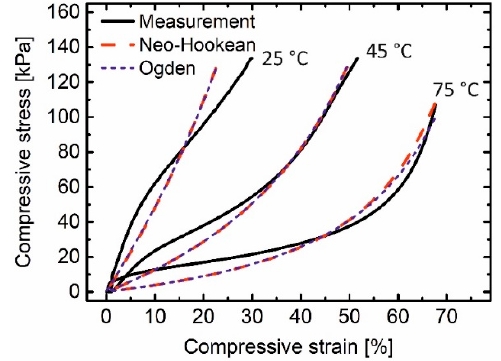
Figure 8. Comparison between the measured stress-strain curves with the ones computed by Neo-Hookean and Ogden model, in which the model parameters were predicted from temperature using the power function.